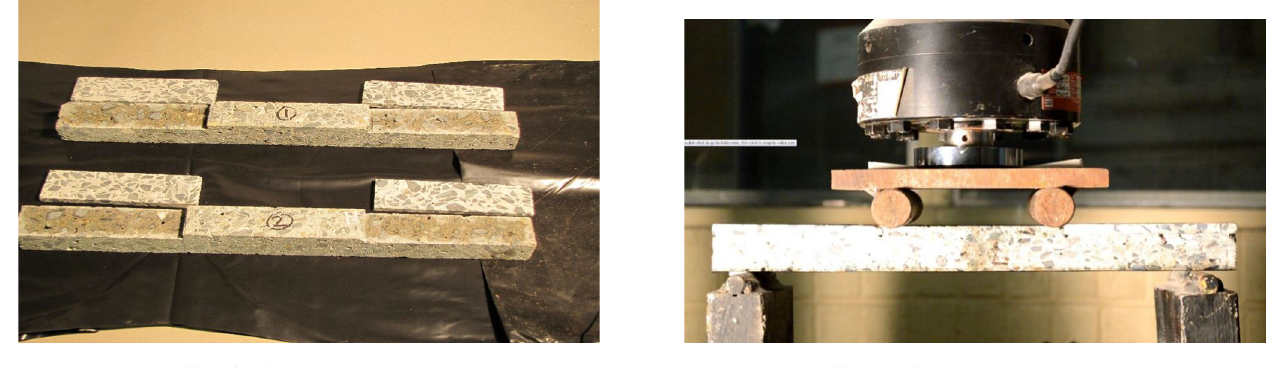
Fig. 4 Prototype beams.